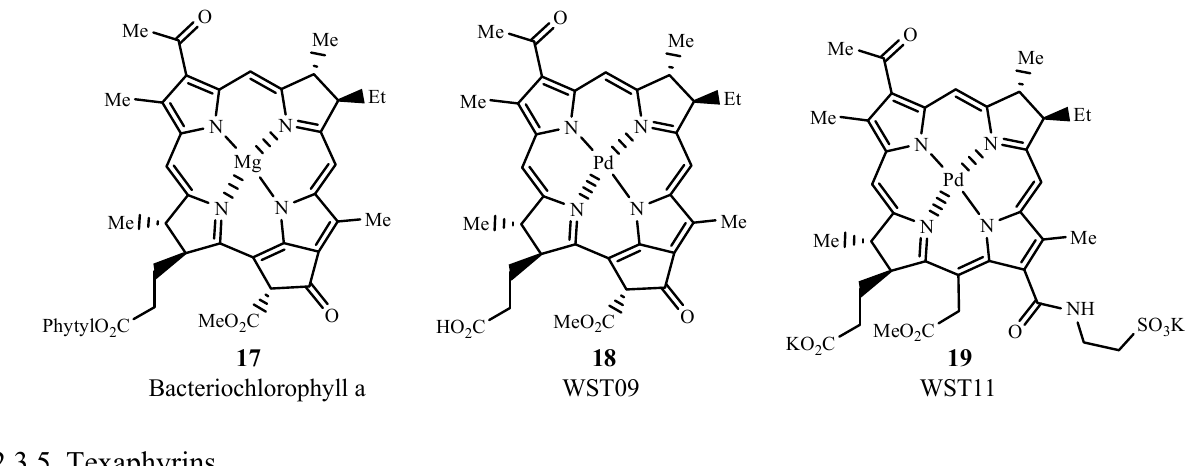
Figure 13. Examples of pheophorbide sensitizers for PDT